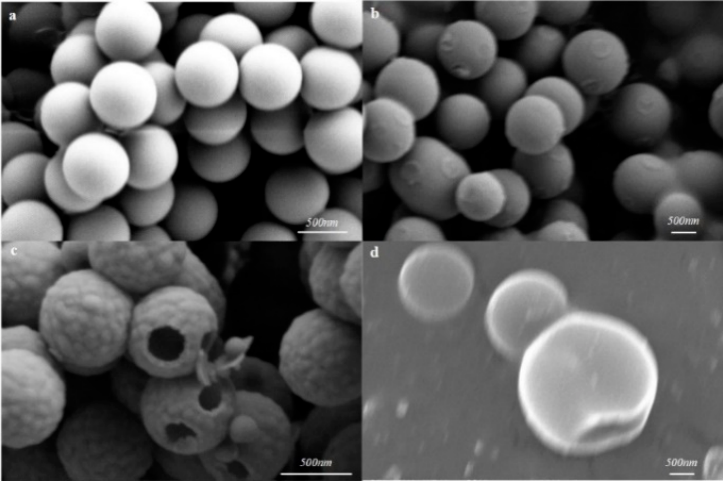
Figure 2. SEM images of PS ( a ), PS@CTAB@Cl@SiO 2 ( b ), MHS ( c ), and MMHSG ( d ).